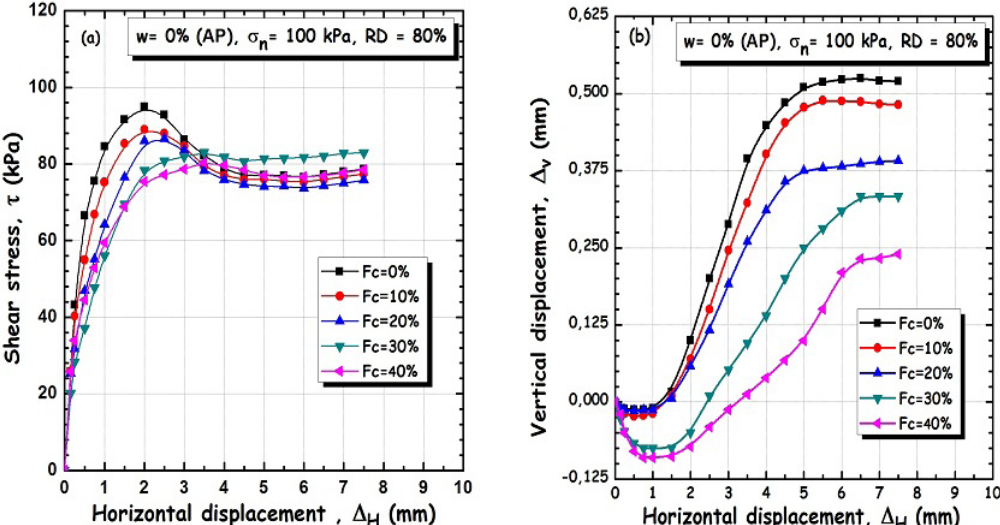
= 100 kPa): (a) variation of the shear n